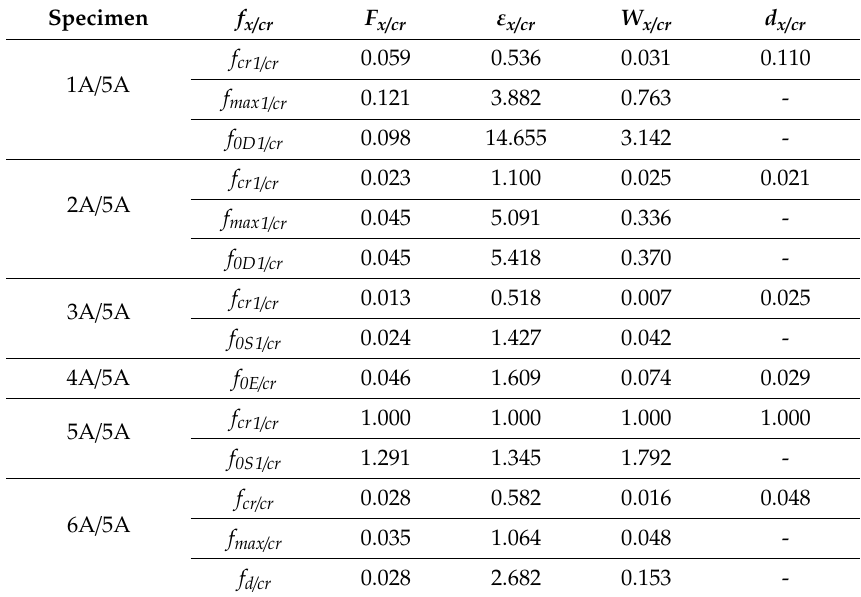
Table 5. Resins 1A, 2A, 3A, 4A, 5A and 6A compared to the linear correlation of specimen 5A.